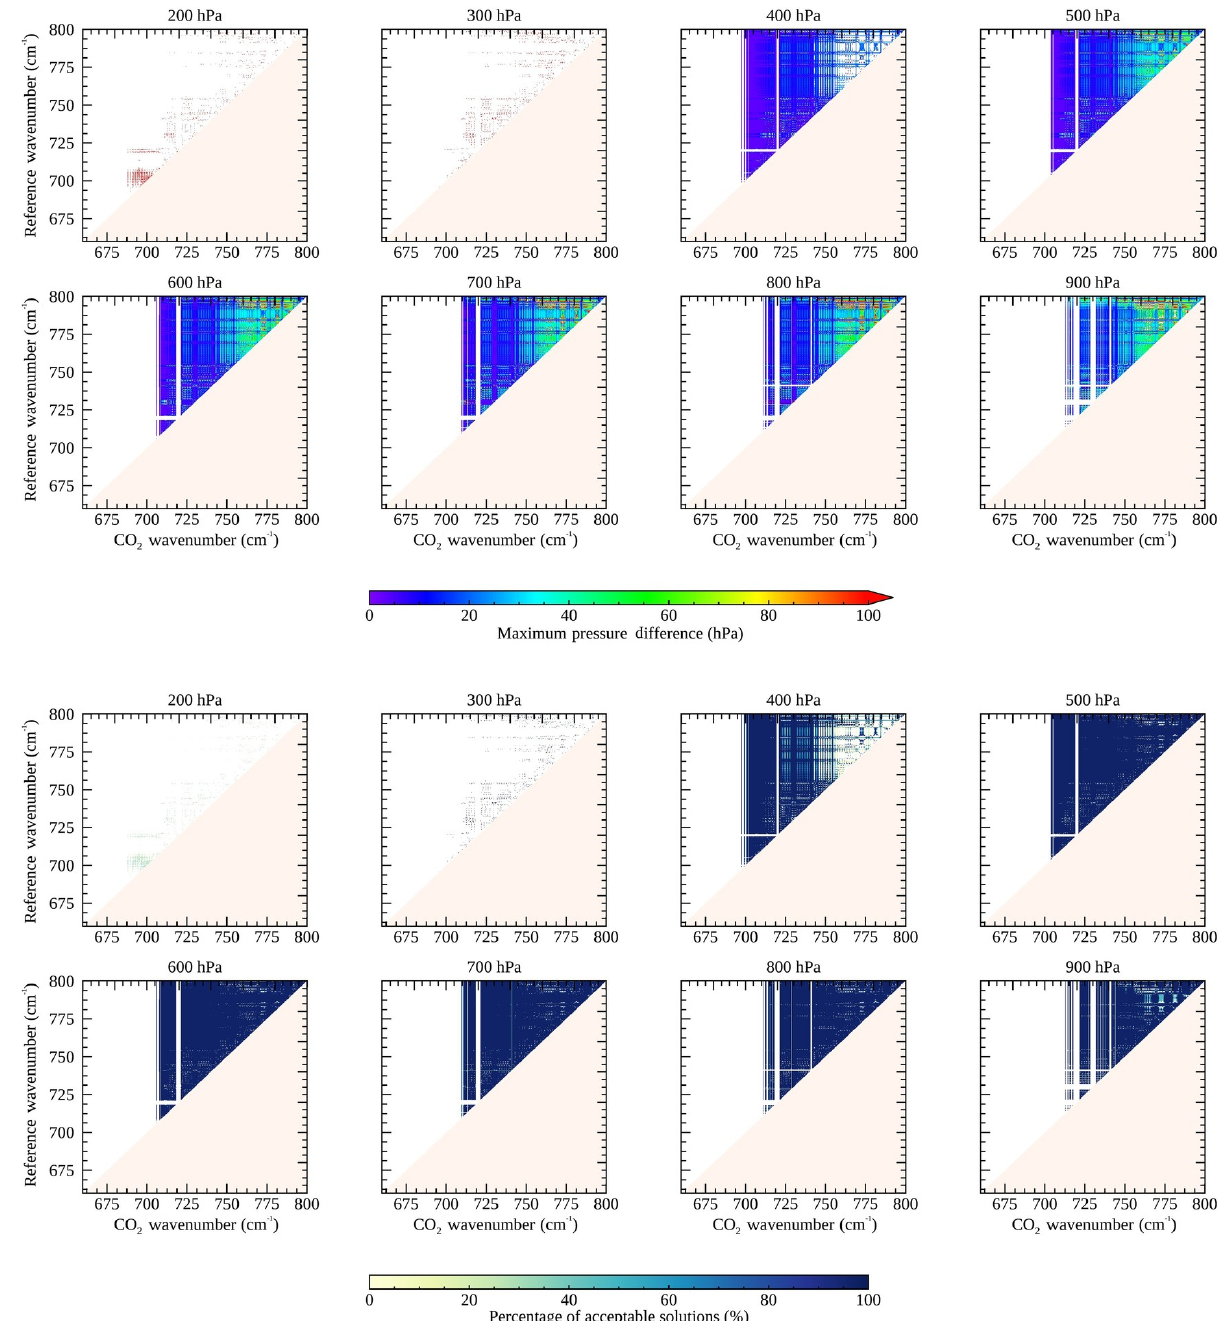
Figure A1. Simulation results for an RTTOV default atmosphere. The top two rows shows the maximum difference between the true (simulated) and retrieved pressures grouped into the different pressure levels. Each level consists of ash optical depths ranging between 5 and 15 and effective radius between 5 and 10µm. The bottom two rows show the percentage of accepted retrievals (i.e. the percentage of cases where there is an intersection between Eqs. 1 and 2 and where all quality control criteria are